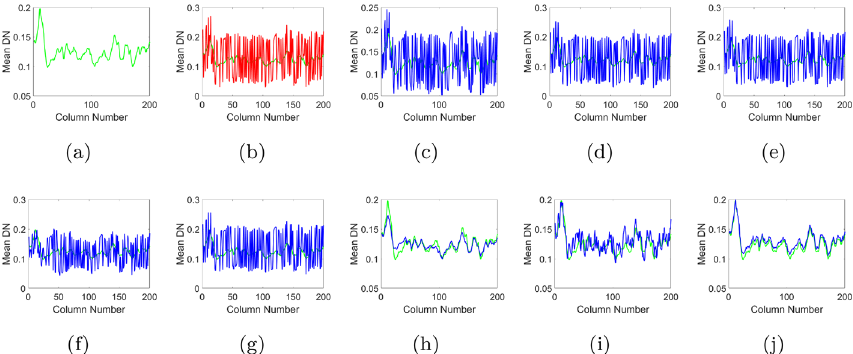
Fig. 3 Vertical mean profiles of band 4 in the Pavia City Center image a Original image; b Noisy image; before and after denoising via the different methods: c BM4D; d LRMR; e NAILRMA; f LLRGTV; g MTGSNMF; h SSTVSSLR; i HSI-SDeCNN; j SRGLR (proposed). The green, red, and blue curves represent the mean DN of the clean, noisy and restored images,